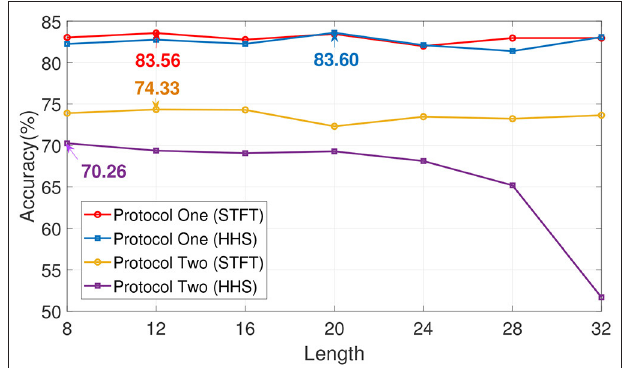
FIGURE 6 | The impact of time length selection on recognition rate. The length of time is in seconds.